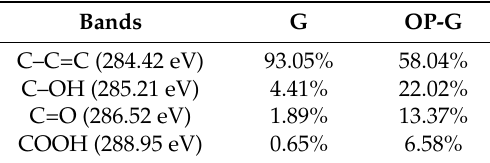
Table 1. XPS analysis of C 1s peak of G and OP-G.